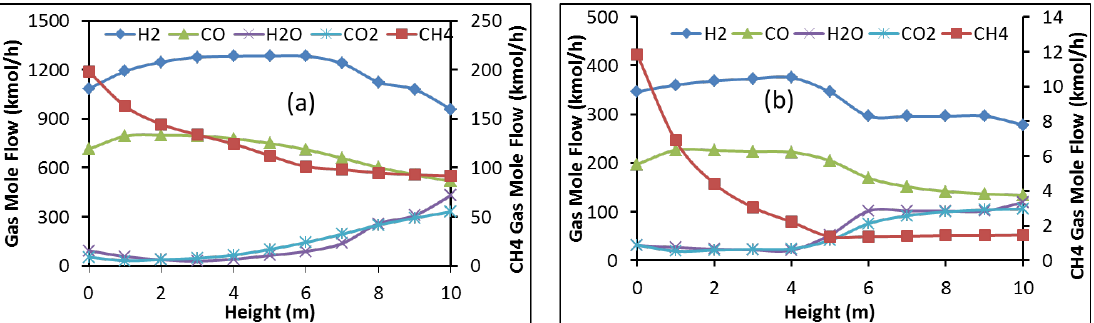
Figure 6. Evolution of the gas component flow rates with shaft height in Zone 1, ( a ) Contrecoeur; ( b ) Gilmore.